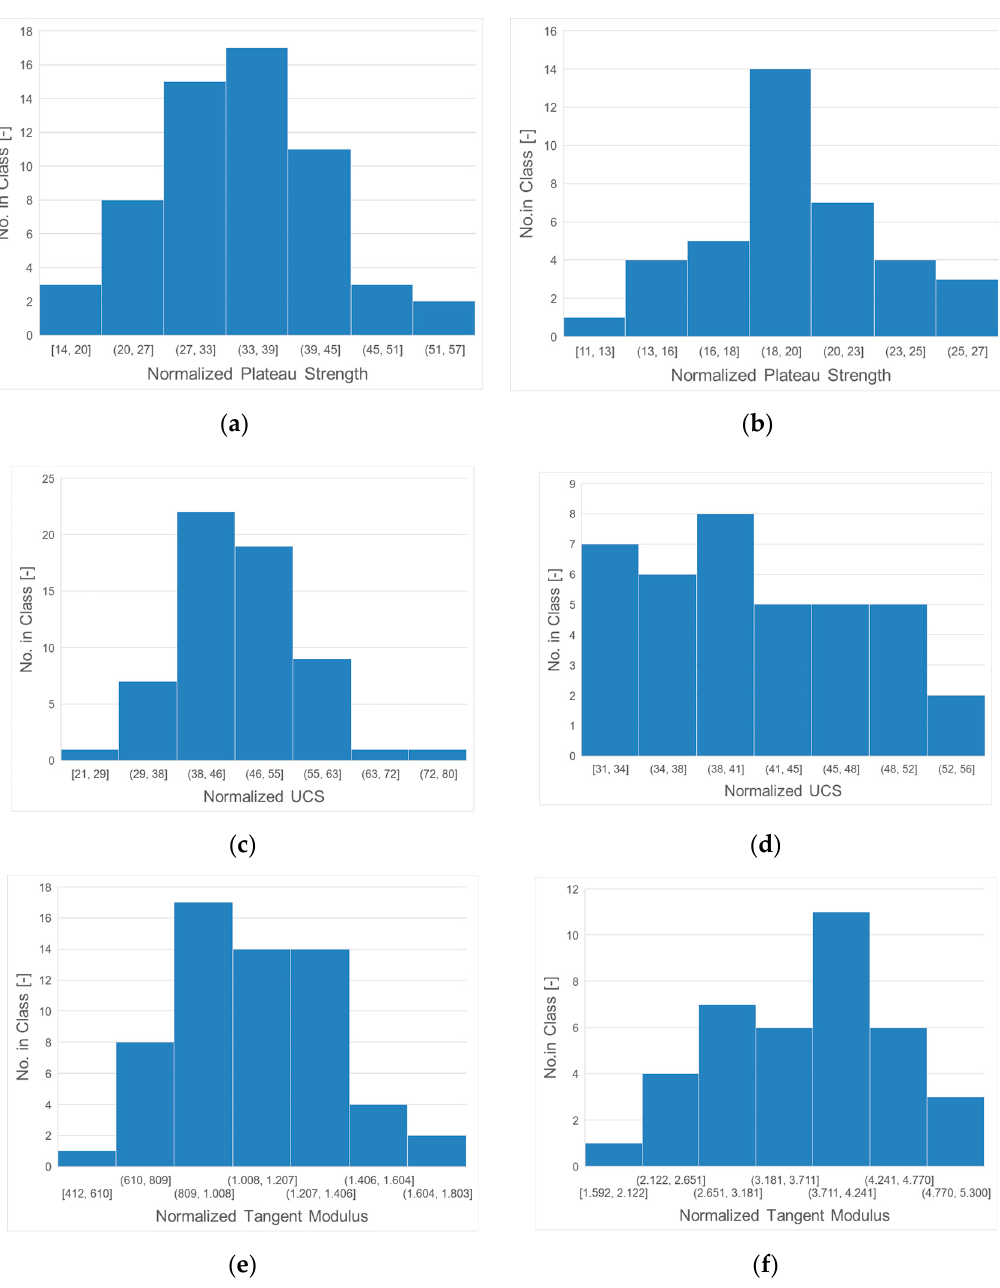
Figure 14. Distributions of normalized properties for the reference material AlS7 expanded using “as received” TiH 2 and the same with added TiB 2 grain refiner—( a , b ), plateau strength, ( c , d ) ultimate compressive strength and ( e , f ) tangent modulus.